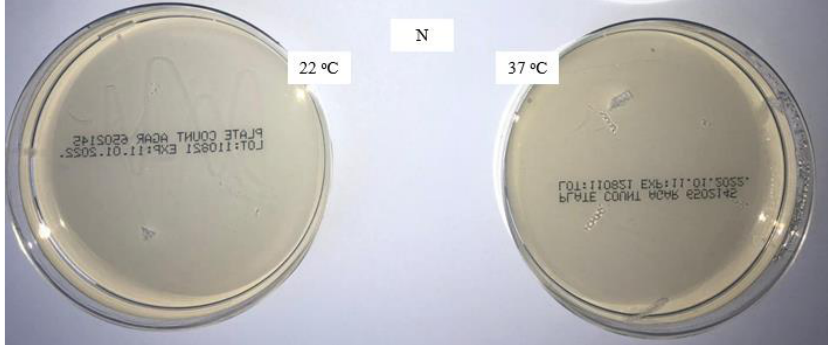
Figure 1. Colonies of aerobic microorganisms on a pristine medical mask (N).